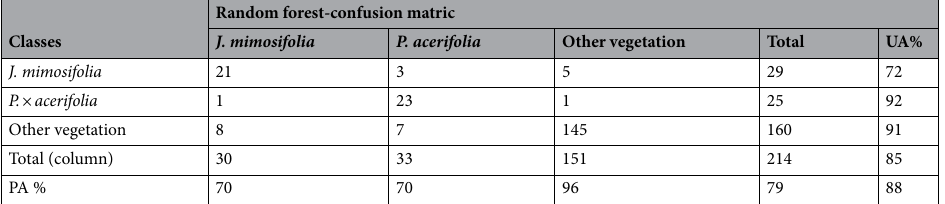
Table 2. Confusion matrix obtained using the Random Forest classifier for land cover types, Jacaranda mimosifolia, Platanus × acerifolia (London Plane) and other vegetation from SPOT 6 imagery of Johannesburg,